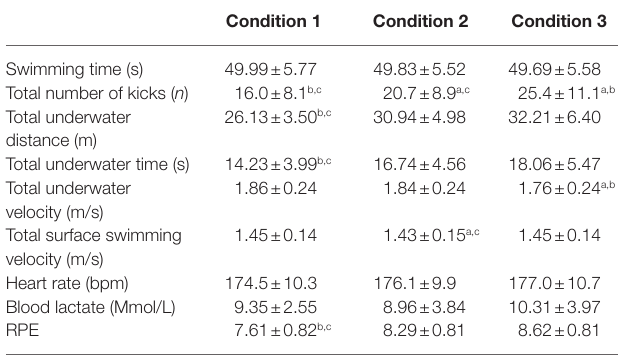
TABLE 2 | Performance, underwater kicking, and physiological parameters of competitive swimmers in different underwater swimming